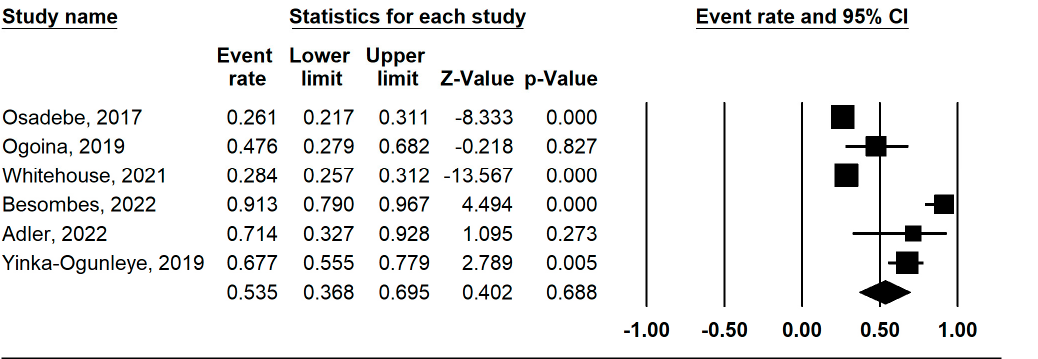
Figure 3. Pooled frequency of genitalia involvement in pre-2022 studies. Osadebe, 2017 [17], Ogoina, 2019 [21], Whitehouse, 2021 [23], Besombes, 2022 [24], Adler, 2022 [26], Yinka-Ogunleye, 2019 [51].